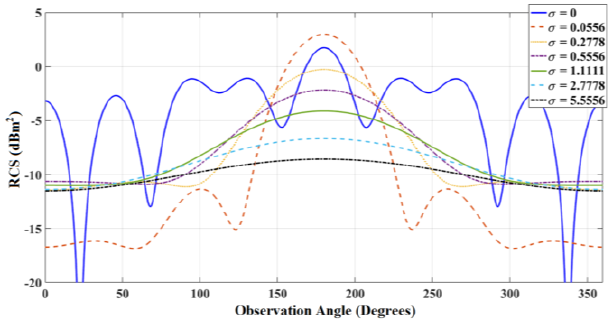
Figure 6: Effect of 𝜎 on RCS The ripples that occur for the lossless case diminish when the scatterer becomes lossy and the fields accumulate around the surface [13]. The structure loses its dielectric scatterer properties as shown above.